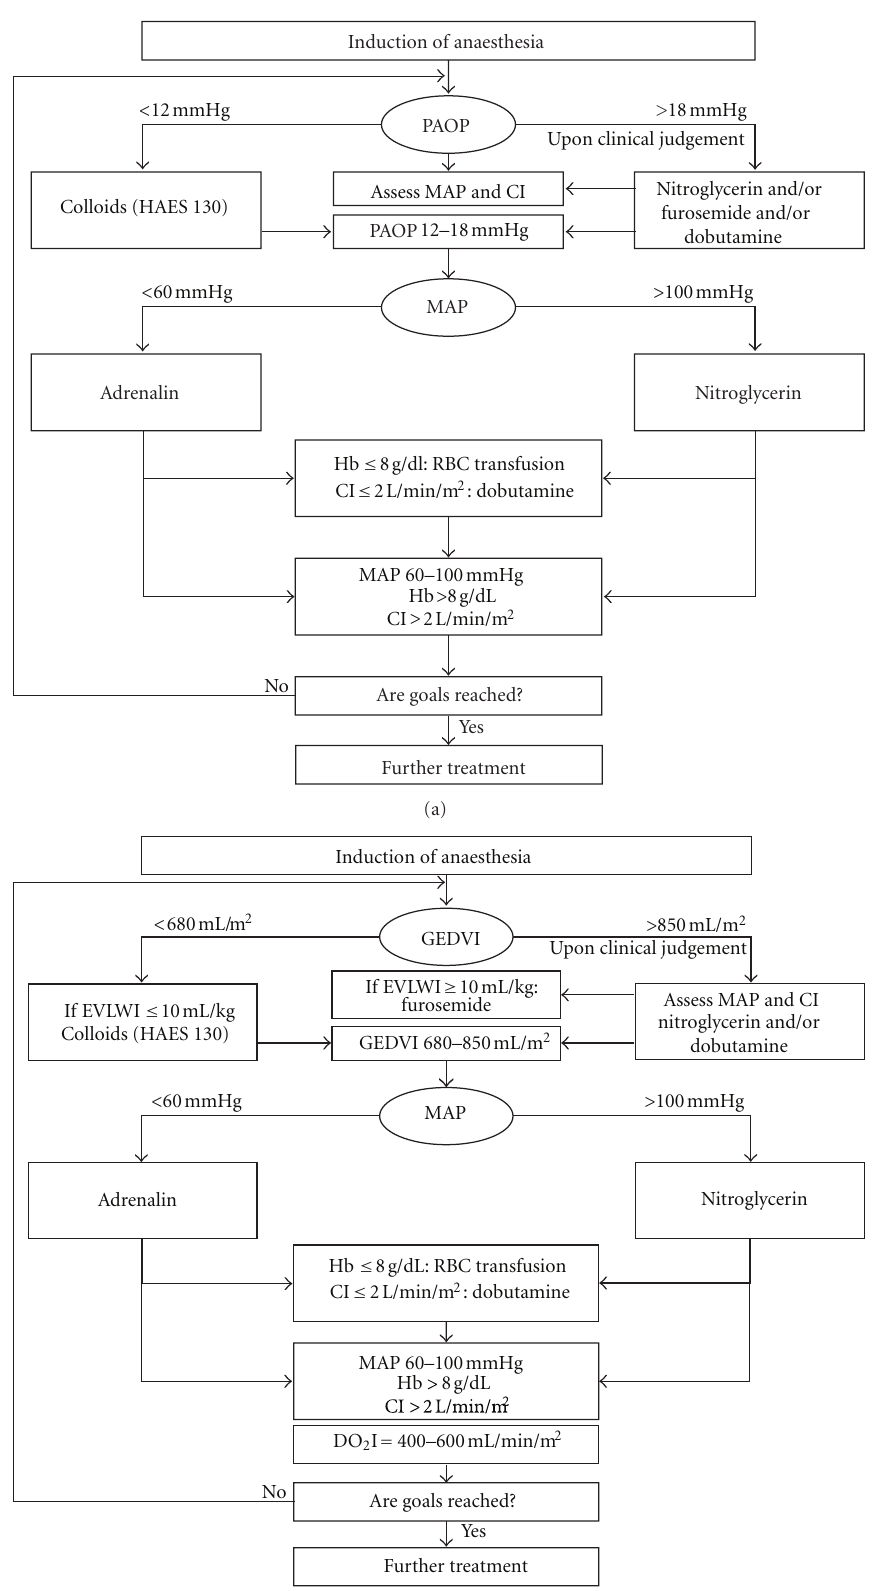
Figure 2: The algorithms of goal-directed hemodynamic optimization: (a) the PAC group, (b) the transpulmonary thermodilution (TTD) group. CPB: cardiopulmonary bypass; MAP: mean arterial pressure; PAOP: pulmonary artery occlusion pressure; CI: cardiac index; GEDVI: global end-diastolic volume index; EVLWI: extravascular lung water index; ScvO 2 : central venous oxygen saturation; DO 2 I: oxygen delivery index; Hb: hemoglobin concentration; RBC: red blood cells; HAES: hydroxyaethyl